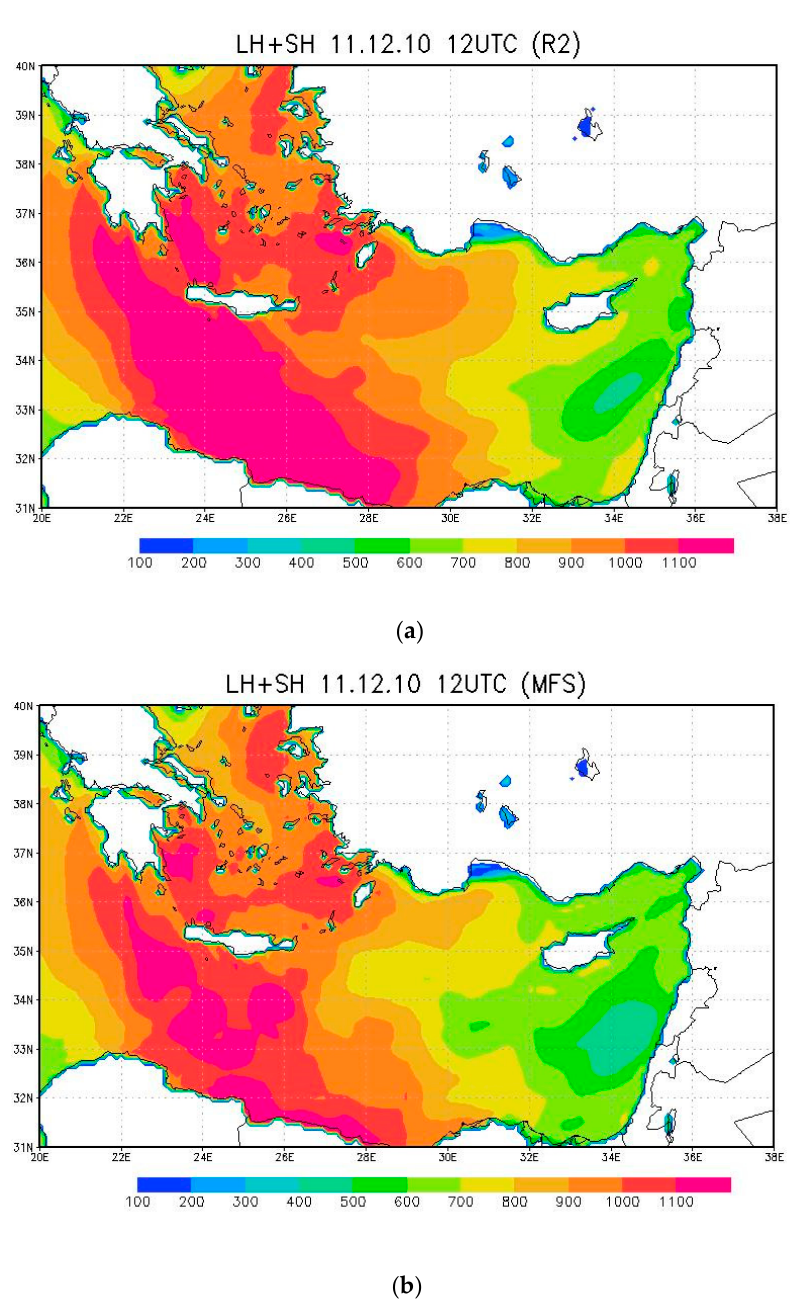
Figure 27. Latent heat + sensible heat flux (W/m − 2 ) on 11 Dec 2010 12 UTC from: ( a ) the R2 run and ( b ) the MFS run.